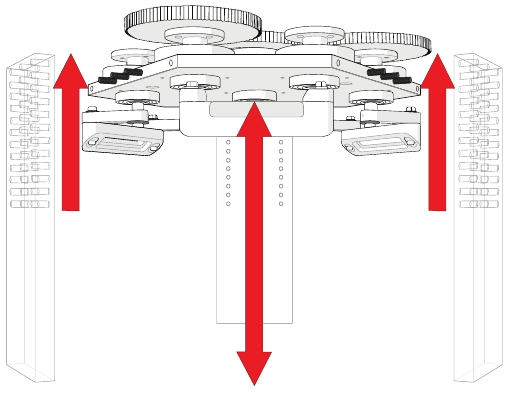
Figure 14: Support design.